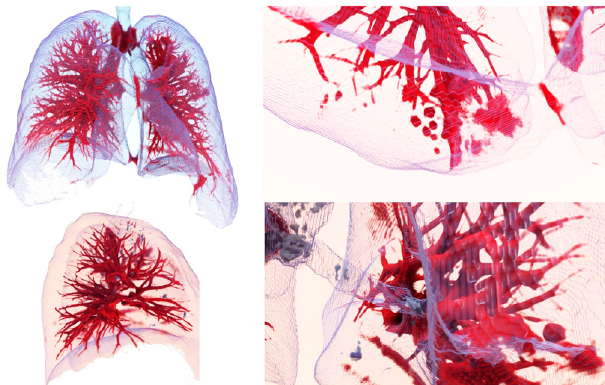
Figure 13. Volume representation of the result of automatic segmentation for lung with blood vessels.